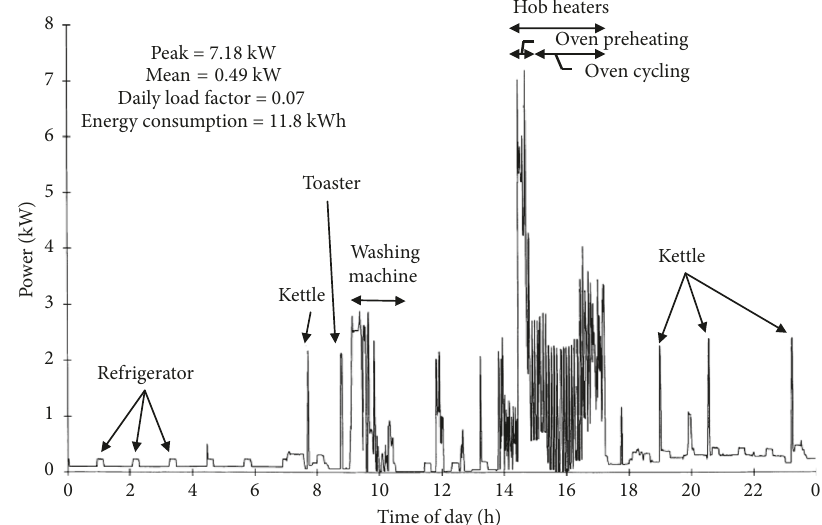
Figure 1: Household profile with devices identified from recordings on a one-minute time base over a 24-hour